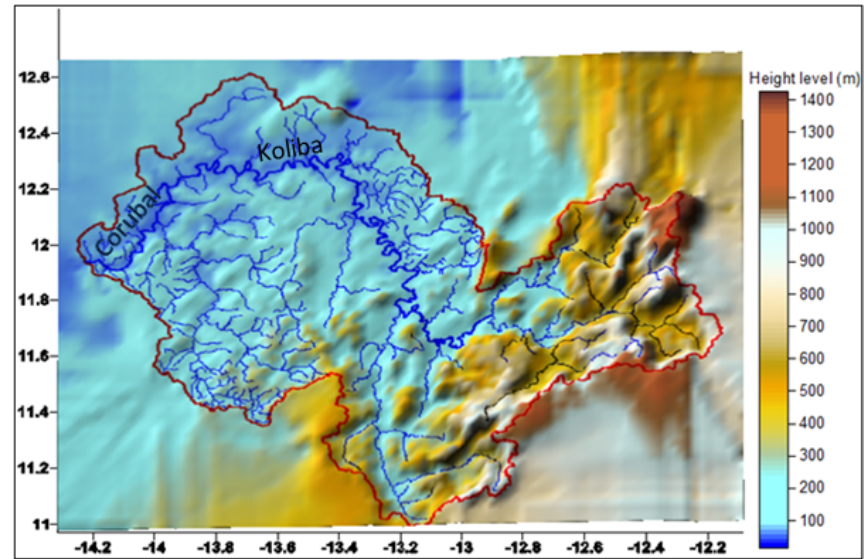
Figure 2. 3D Digital Terrain Model of the Koliba/Corubal Basin at